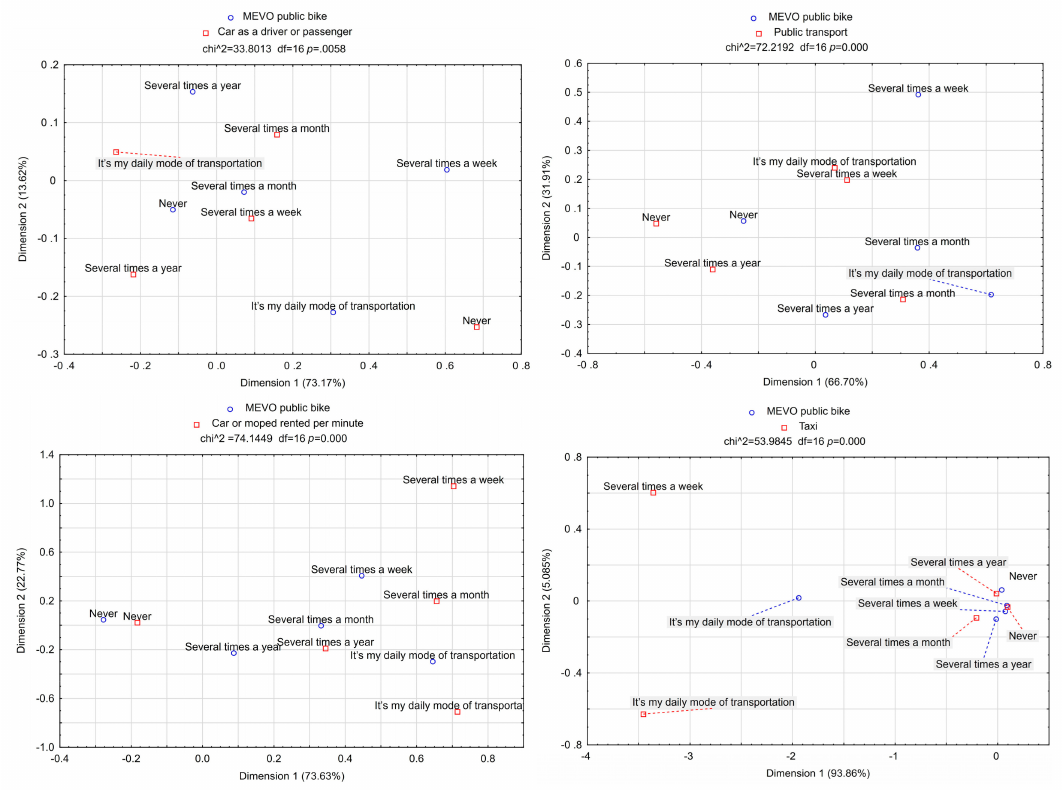
Figure 3. Correspondence analysis: The frequency of using the Mevo public bike system and other means of transport. Source: Author’s own